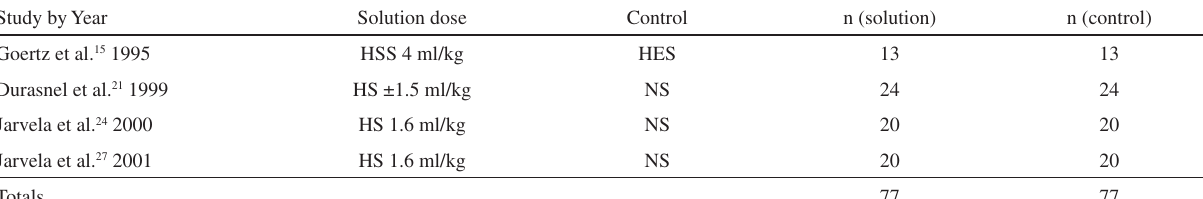
Table 5 - Perioperative studies on the use of hypertonic saline 7.2-7.5% NaCl) alone or in association with hydroxielthyl starch (HSS) compared to hydroxiethyl starch (HES) or normal saline (NS) in minor surgeries and before spinal anaesthesia Study by